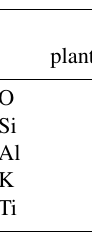
Table 3. Chemical composition of major elements at Gludsted plan- tation determined using X-ray fluorescence analysis on soil samples collected in 0.20–0.25m